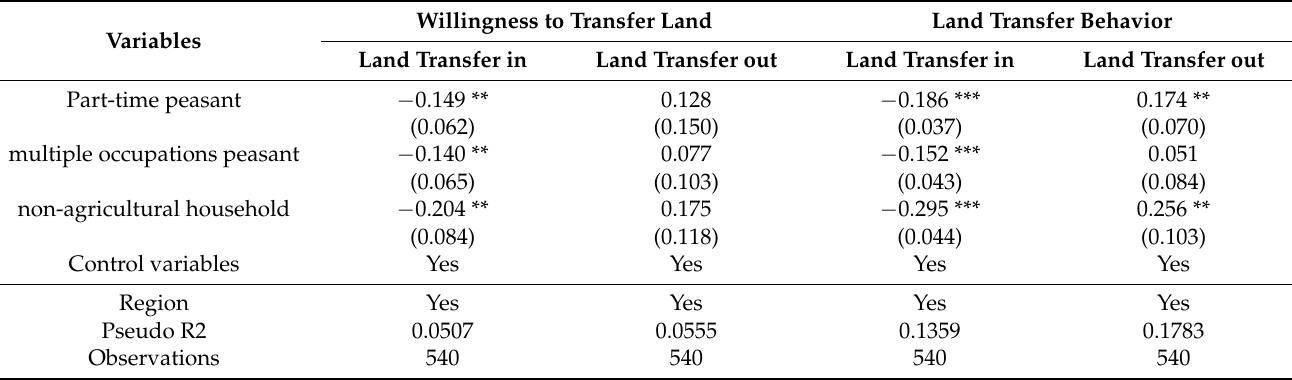
Table 4. Robustness tests for a model replacement method.